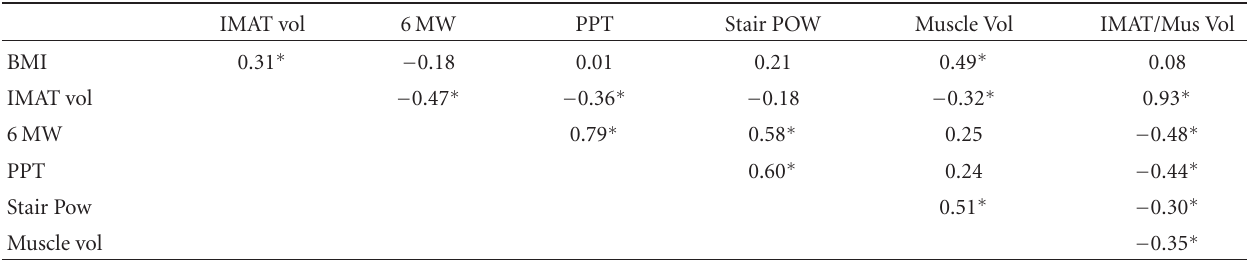
Table 4: Correlation